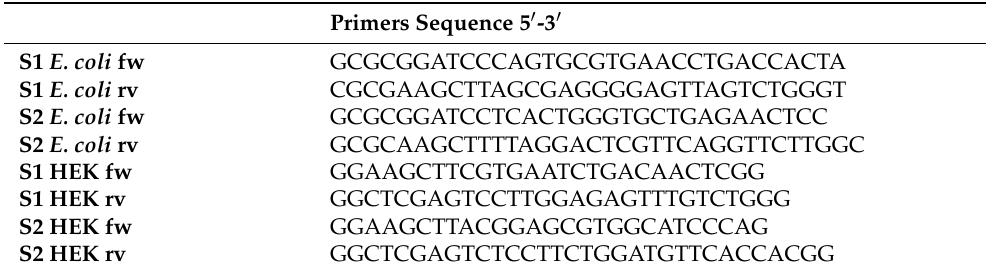
Table 1. List of primers used for the generation of recombinant proteins. Primers Sequence 5 (cid:48) -3